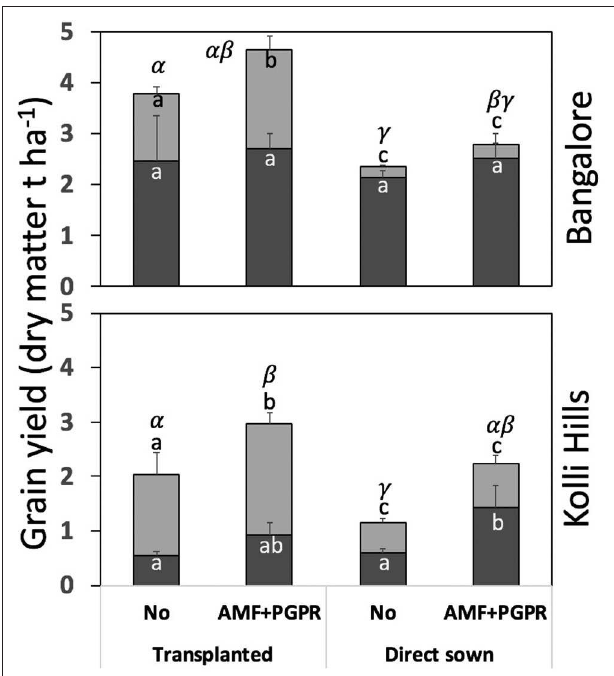
FIGURE 6 | Effect of no inoculation and combined application of AMF and PGPR on grain yields of finger millet (dark shaded bars) and pigeon pea (light shaded bars) in transplanted vs. direct sown intercropping system at Bangalore and Kolli Hills during the season 2016-17. Significant differences among means were calculated for total yield of finger millet and pigeon pea. Each error bar indicates + 1 standard deviation of the mean. Alpha ( α ) and beta ( β ) above the bars indicate letters of significance for combined grain yields of finger millet and pigeon pea. Bars not sharing the same letters are significantly different from each other at p <